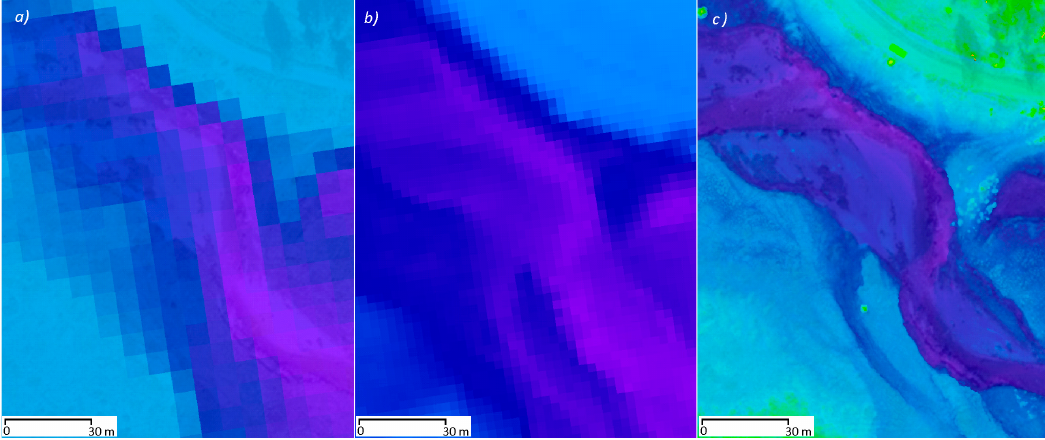
Figure 15. Difference in channel schematizations. ( a ) DMR4G; ( b ) DMR5G; ( c ) 2 m digital elevation model (DEM) from unmanned aerial systems (UASs).